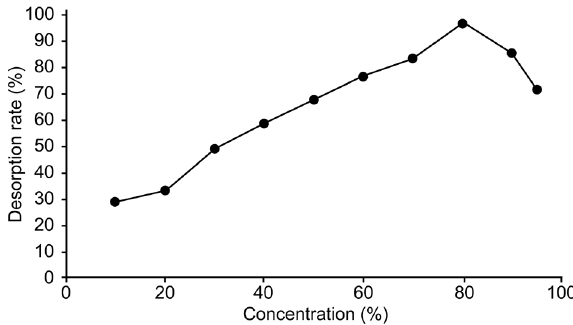
Figure 6: Desorption rate at different eluent concentrations.